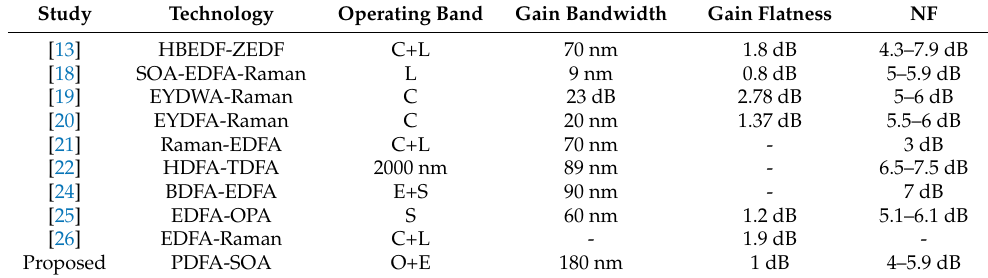
Table 1. Literature review of